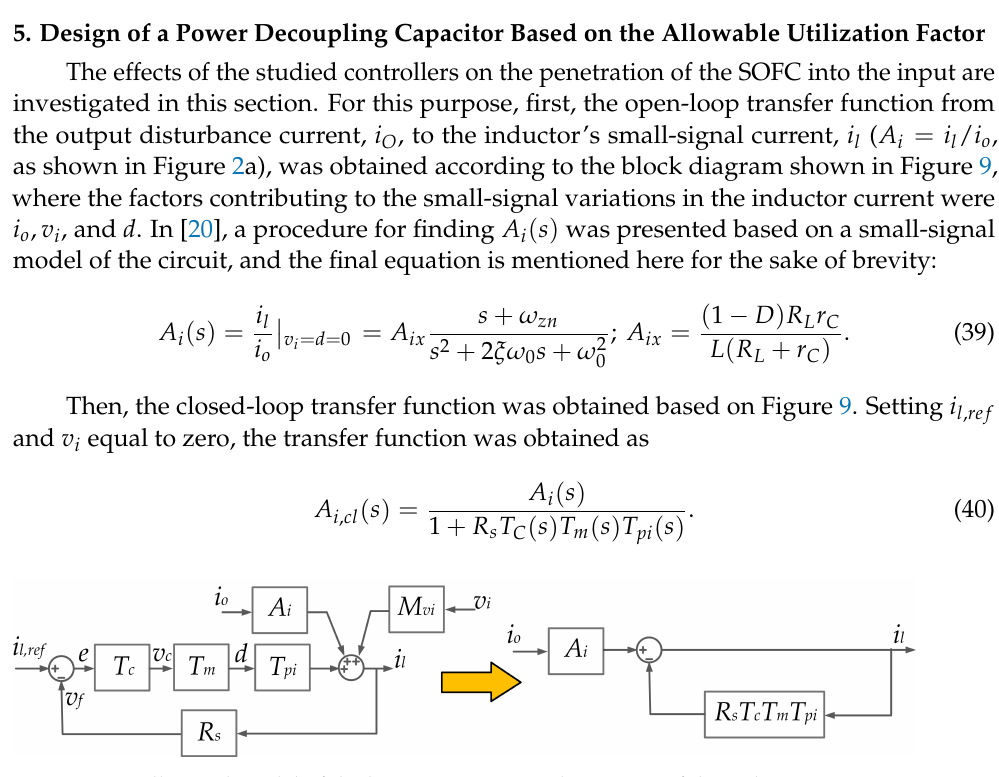
Figure 9. Small-signal model of the boost converter in the ACMC of the inductor